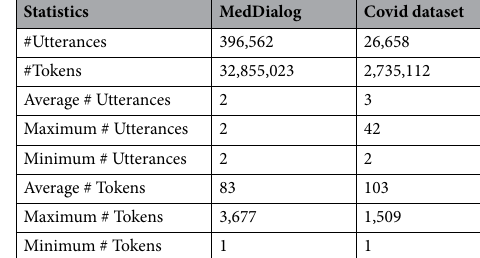
Table 5. Dataset